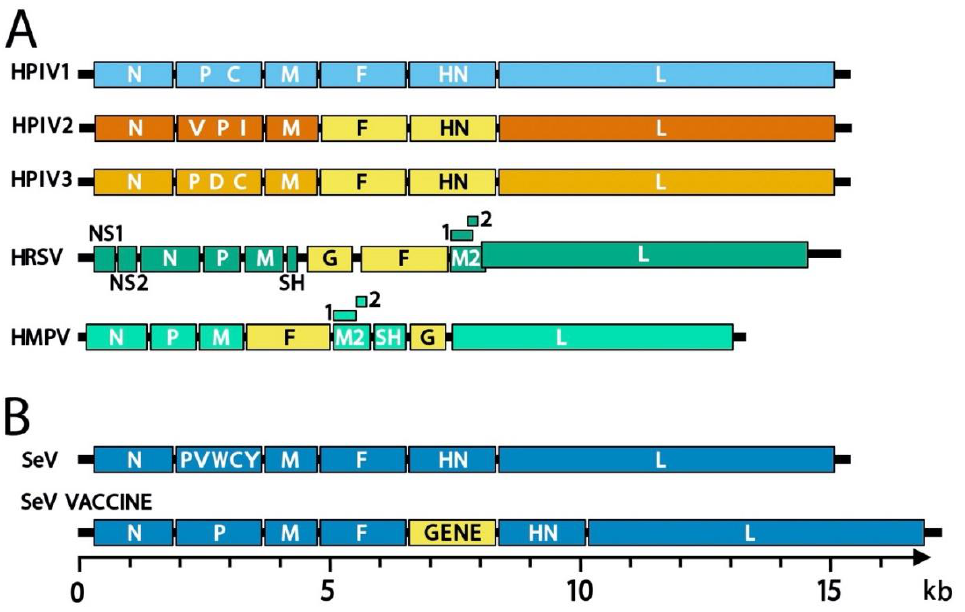
Figure 5. Genome structures of representative paramyxoviruses and pneumoviruses. ( A ) Genomes of human vaccines targeted by SeV-based vaccines. Due to high amino-acid similarity, unmodified SeV serves as a Jennerian vaccine against HPIV1. For the other human viruses, an envelope glycoprotein gene (yellow) is inserted into the SeV genome. ( B ) Sendai virus vaccine genome structures. The envelope glycoprotein gene (GENE, yellow) from a human virus may be inserted into any gene junction of the SeV genome. Most SeV-vectored vaccines studied in preclinical experiments contain a foreign gene inserted between the F and HN genes as shown. In the genomes, the 3 (cid:48) leader is on the left and the 5 (cid:48) trailer is on the right. Intergenic junctions (not shown) include a transcription stop, intergenic, and transcription start sequences. Genomes are drawn to scale with a scale bar at the